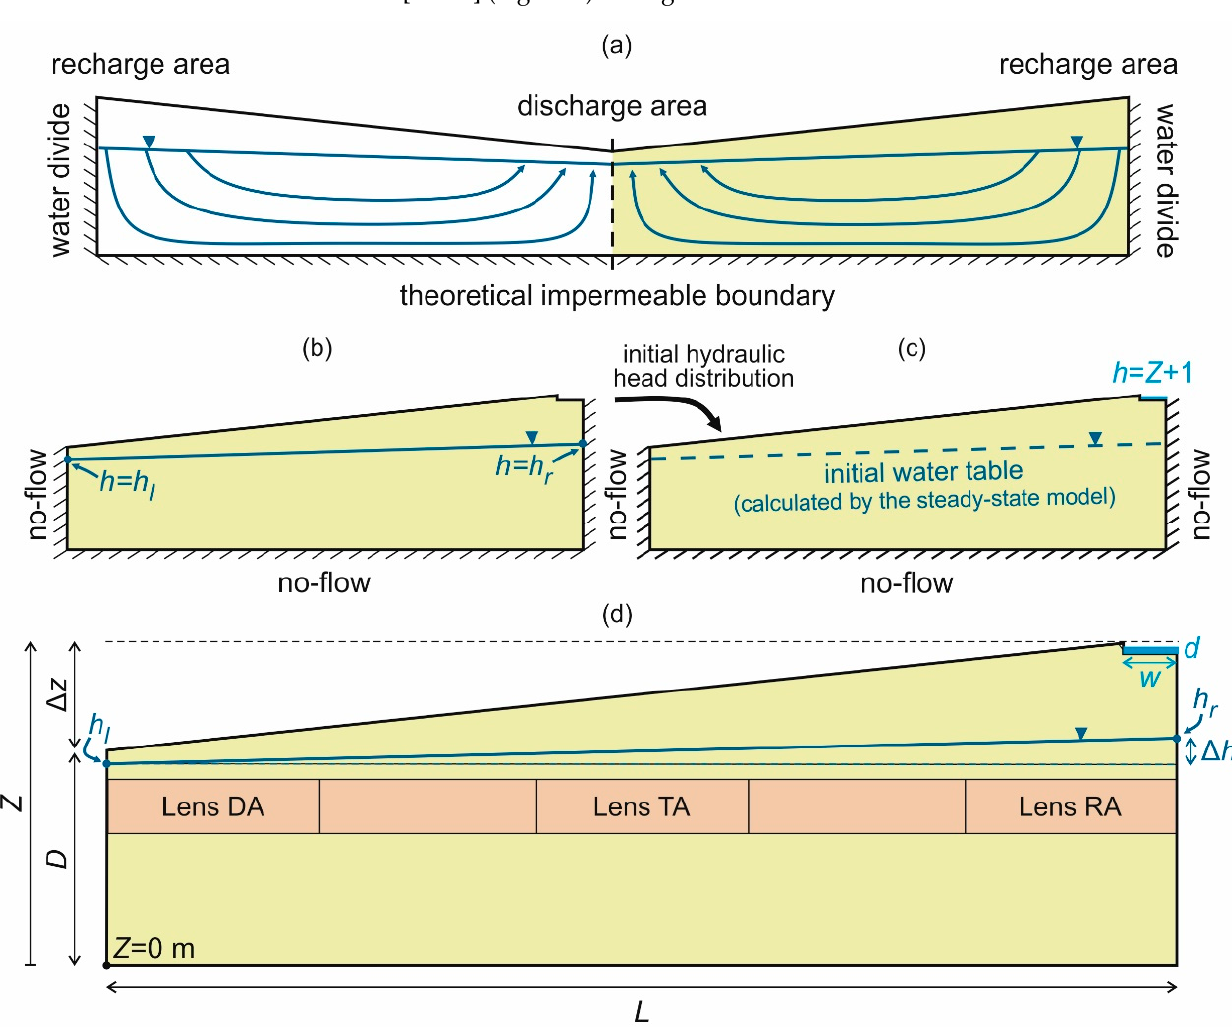
Figure 1. ( a ): The applied theoretical approach for a simple half ‐ basin adapted from Tóth [59]. ( b ): Boundary conditions in the steady ‐ state flow simulations. ( c ): Boundary conditions in the transient flow simulations. ( d ): The geometry, the geology, and the model parameters. The effect of heterogeneities was studied in the SG-5 scenarios (abbreviations: RA—below the recharge area, TA—below the throughflow area, DA—below the discharge area).